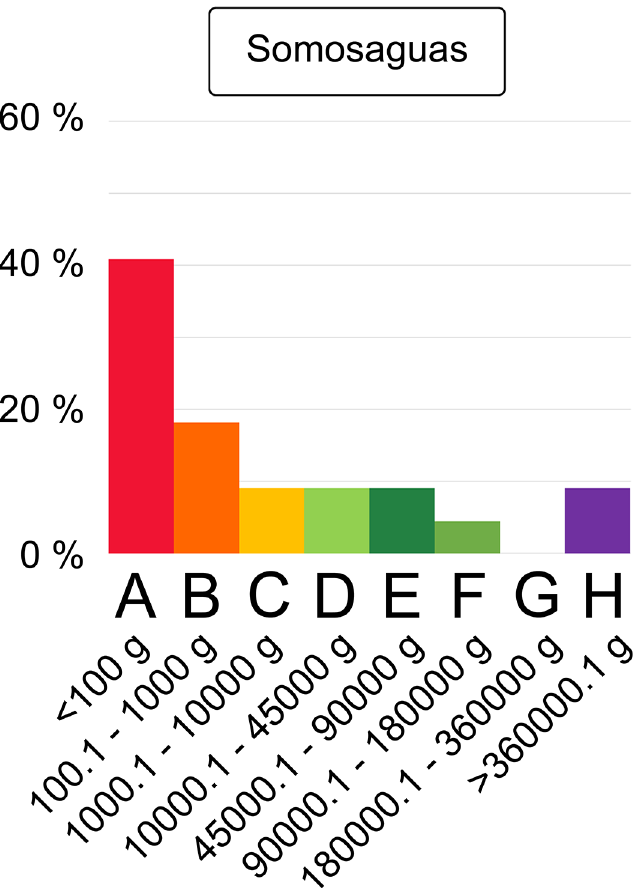
Fig 8. Mammalian body-size structure of the Somosaguas fossil site. Categories as in Table